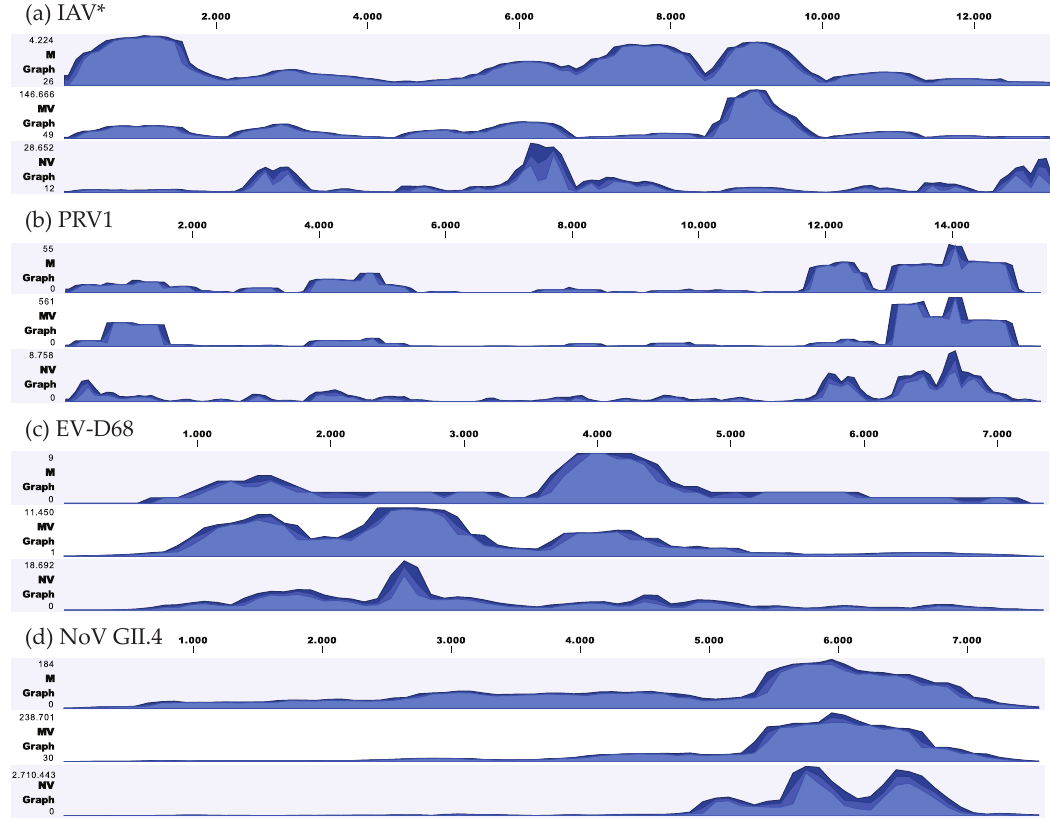
Figure 3. Visualization of the coverage depth for four clinically relevant viruses detected in our study. ( a ) Influenza A virus; ( b ) Porcine respirovirus 1; ( c ) Enterovirus D68; ( d ) Norovirus GII.4. Reads were not normalized and therefore actual depth was dependent on the number of total reads of the sample. * All 8 influenza A virus segments were concatenated into a single genome. Abbreviations: M, MinION; MV, MinION with ViroCap; NV, NextSeq with ViroCap; IAV, influenza A virus; PRV1, porcine respirovirus 1; EV-D68, enterovirus D68; NoV GII.4, norovirus